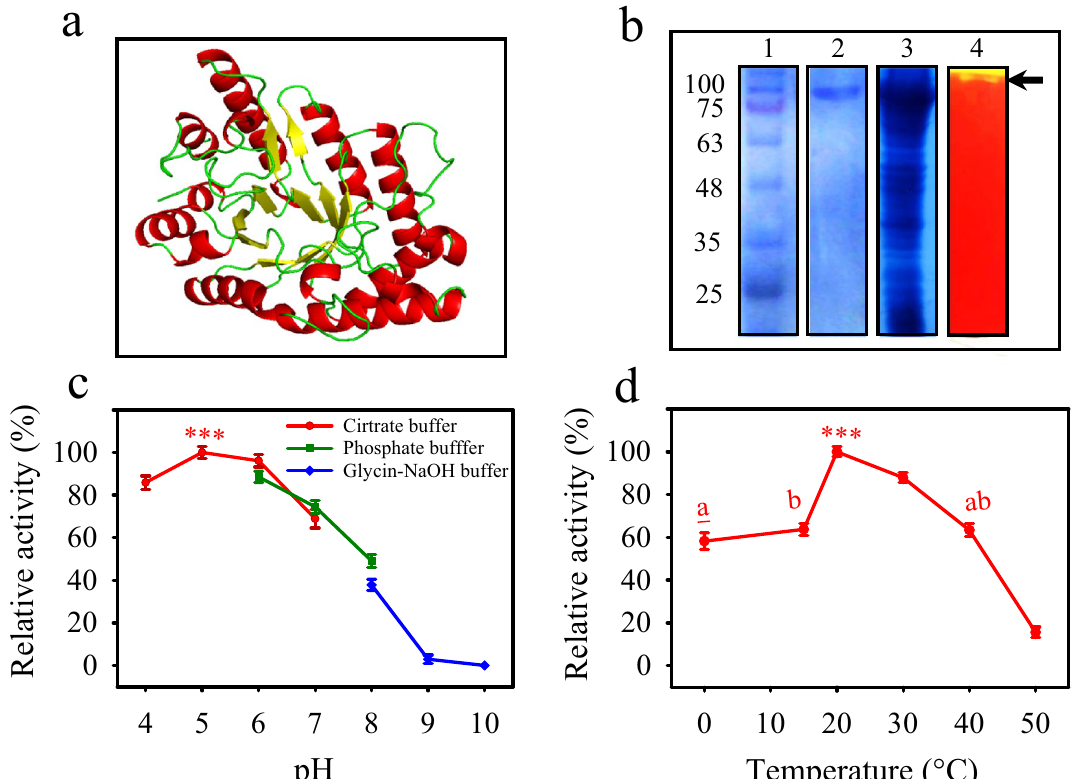
Figure 1. ( a ) Modeled structure of Xyn-2. The (β/α) 8 barrel is a characteristic feature of family 10 xylanases ( b ) SDS-PAGE and native PAGE of purified Xyn-2. Lane 1—molecular weight marker, lane 2—purified Xyn-2, lane 3—cell lysate of E. coli BL21(DE3) expressing Xyn-2, lane 4—native PAGE and activity staining of Xyn-2 with Congo-red (from supplementary Fig. S3). The arrow indicates the yellowish band of xylan hydrolysis ( c ) Effect of pH on the activity of Xyn-2 measured by running reactions in various pH buffers at 35 °C. The highest enzyme activity, obtained at pH 5, was taken as 100%, and the enzyme activities obtained at other